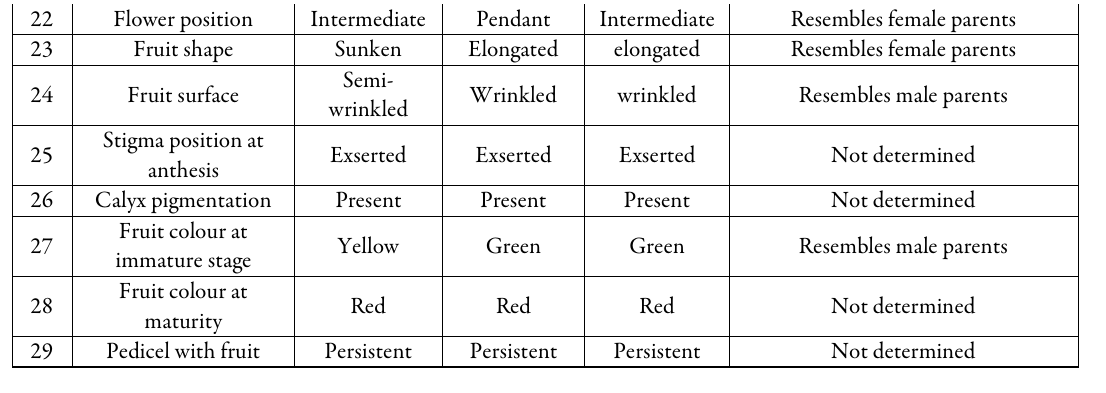
Table 8. Comparison of T and R Determination of dominance between